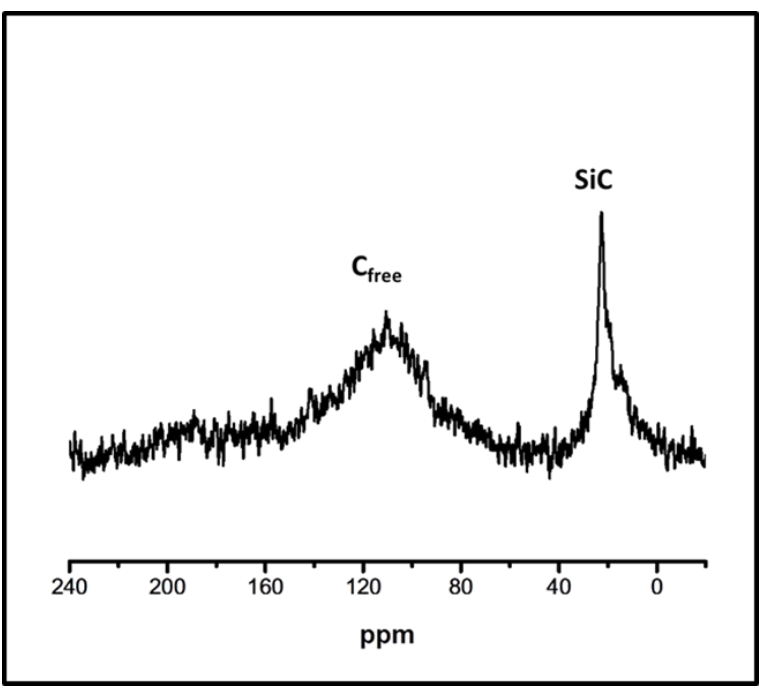
Figure 5. 13 C MAS NMR spectra of ceramic SiC/C f microspheres obtained by ceramization of polysiloxane microspheres at 1600 °C for 5 h under argon; DVB/PHMS w / w ratio 0.97 (A-6).